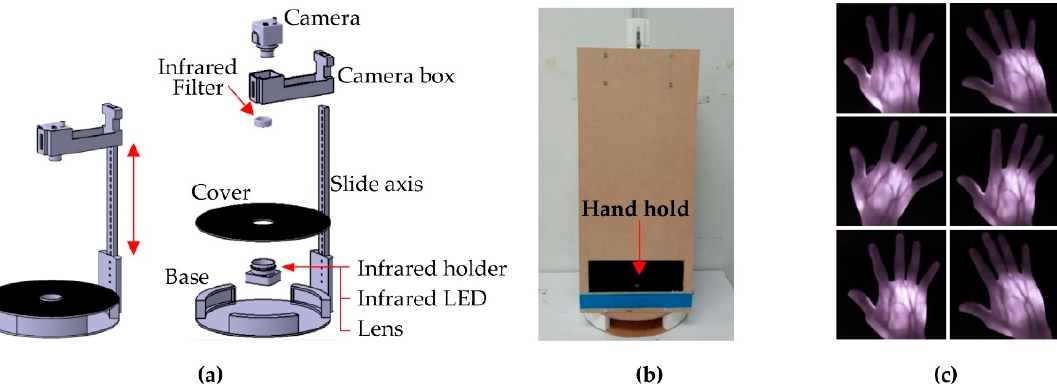
Figure 2. Image acquisition system design. ( a ) Setup, ( b ) design and construction, ( c ) samples of acquired images.